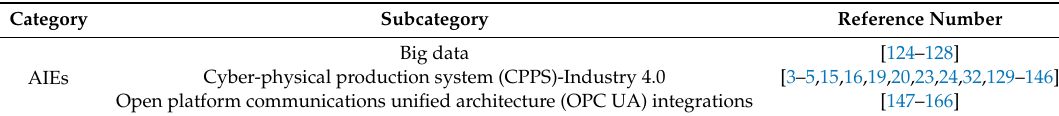
Table 5. Publications in the category of advanced industrial environments